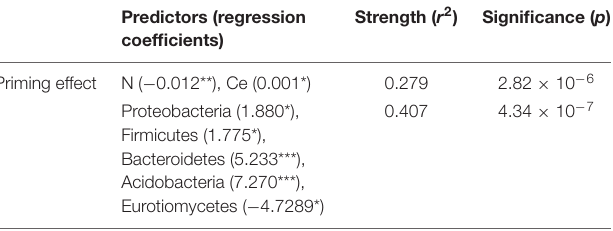
TABLE 2 | Outcome of determination of stepwise regressions between litter chemical traits and specific microbial taxa and soil priming